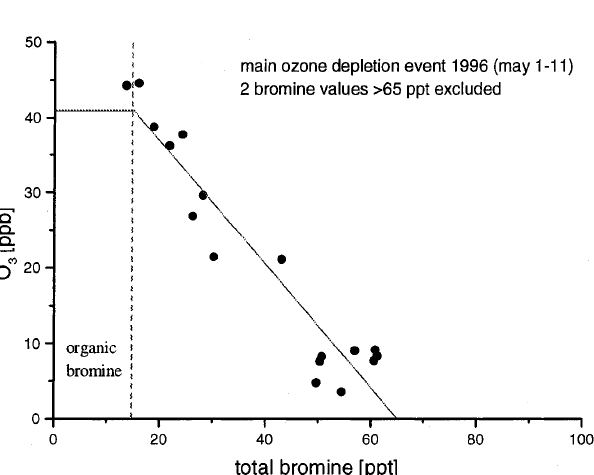
Fig. 10. O 3 mixing ratio as function of total bromine, main ozone depletion event 1996